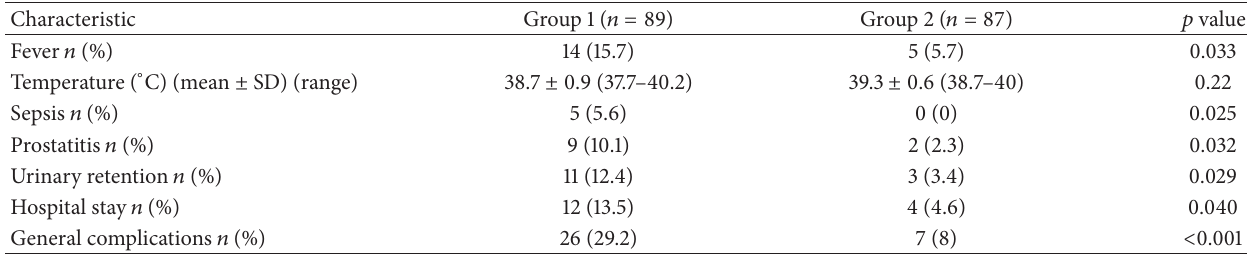
Table 2: Distribution of complications according to groups.